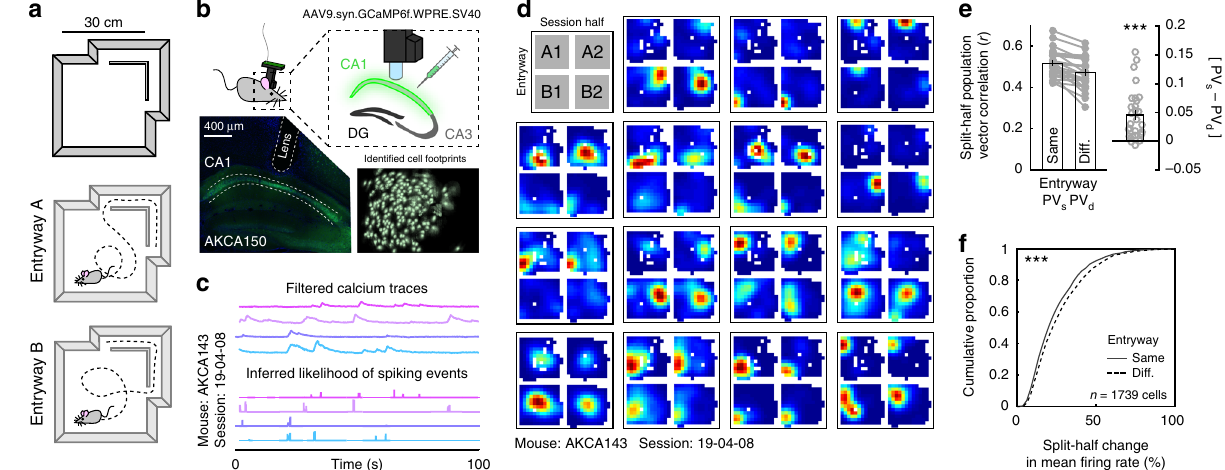
Fig. 1 The CA1 rate code depends on entryway. a Schematic of the recording environment. b One-photon calcium recording setup, with an example of viral expression (lower left) and the spatial footprints of cells extracted from the in vivo recorded calcium signal for an example session (lower right). c Example of extracted fi ltered calcium traces (top) and the resulting inferred likelihood of spiking events (bottom). d Example rate maps from 15 simultaneously recorded place cells when the data are divided by most recent entryway and session half. Rate maps are normalized from zero (blue) to the peak (red) across all four maps. e Split-half correlations of population activity within the compartment when the mouse entered from the same versus the different entryway. Each dot represents one session from one mouse. Data are from 29 sessions from 5 mice. Correlations were signi fi cantly higher when the mouse entered from the same entryway (Wilcoxon signed-rank test: Z = 4.573, p = 4.80e – 6). f Cumulative distribution of split-half changes of mean fi ring rates within the compartment when the mouse entered from the same versus the different entryway. Mean fi ring rates were signi fi cantly more similar when the mouse entered from the same entryway (Wilcoxon rank-sum test: Z = 4.209, p = 2.56e – 5). All bar graphs re fl ect mean ± 1 SEM; p -values are uncorrected and two-sided. Data from ( e , f ) provided as Source data fi le. *** p <